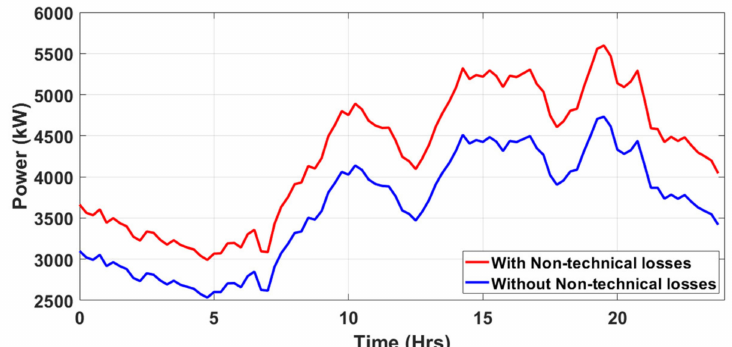
Figure 7. Injected active power in the IEEE- 123 bus test system under both loading conditions: without irregular loads (blue) and with irregular loads